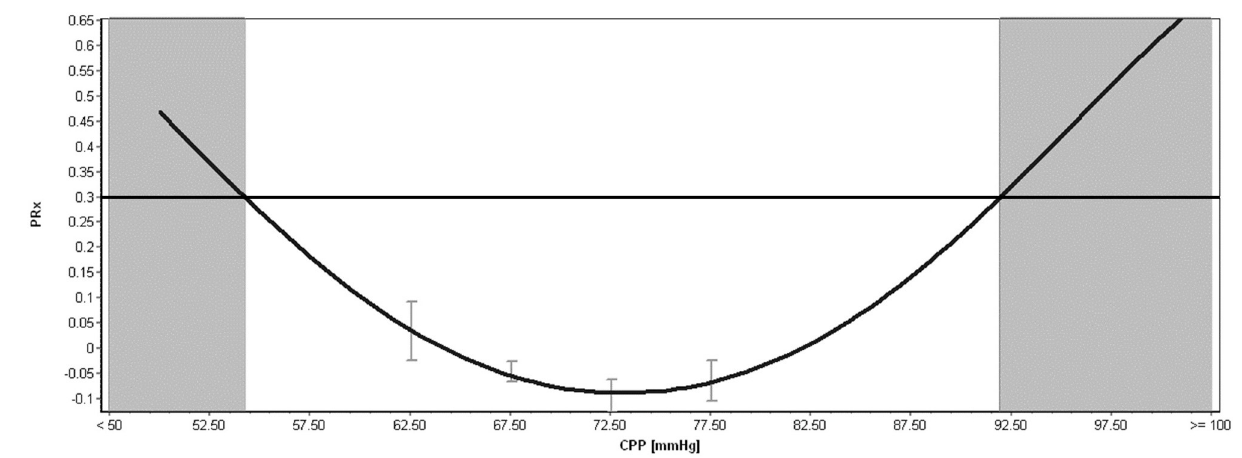
FIGURE 3 | Example of Individualized Optimal CPP, Upper and Lower Limits of Regulation Calculation in Moderate/Severe TBI. CPP, cerebral perfusion pressure; mmHg, millimeters of Mercury; PRx, pressure reactivity index for cerebrovascular reactivity monitoring. The above plot shows an example of individualized optimal CPP estimation, calculated through error-bar plots of PRx vs. CPP and the fitting of a parabolic curve to the relationship. The minimum of this parabolic distribution represents the optimal CPP, based on the past 4-h of data. The shaded areas represent the lower limit of regulation (LLR; on the far left of the figure) and the upper limit of regulation (ULR; on the far right of the figure). The area in-between these two shaded zones represent a theoretical safe CPP range where autoregulation is mostly preserved (i.e., < + 0.30), which in this example is a wide CPP range. Both the optimal CPP and LLR/ULR is continuously calculated over time using sliding windows of data, leading to continuously updating individualized bedside targets. Data taken from previously published and approved studies (University of Manitoba REB: H2017:181, H2017:188 and H2020:118) ( 9, 10, 32–35).